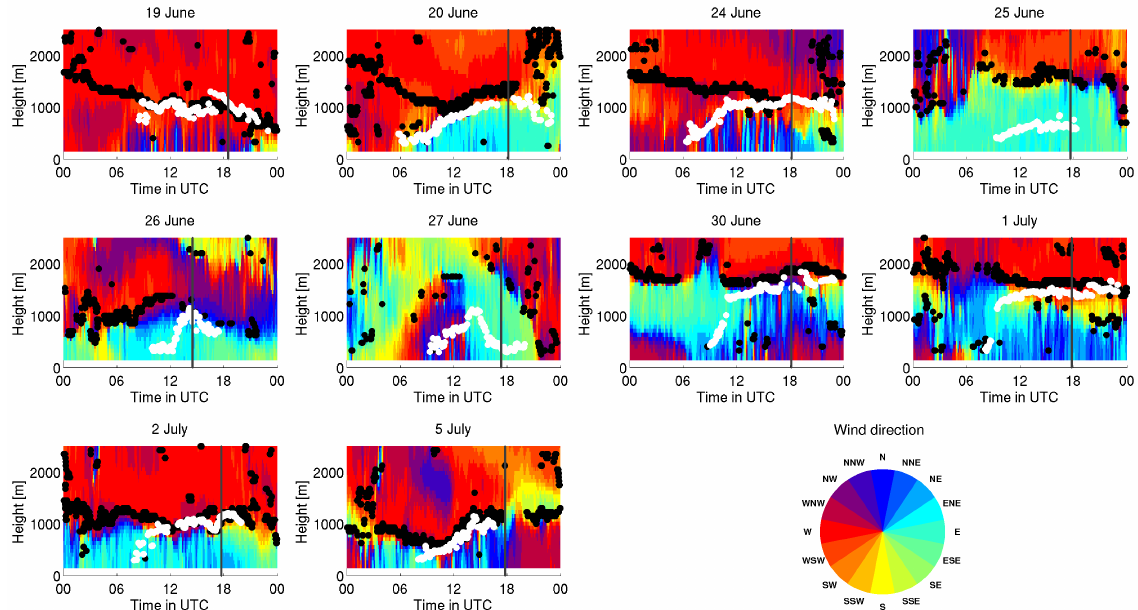
Figure A2. Wind direction from UHF profiler data between 175 and 2500m. The strongest wind speed gradient identification (black dots) most of the time separates the large-scale westerly flow above from the flow below. During daytime the flow below in the boundary layer is often easterly (or northerly). Also shown in white are the boundary layer depth estimates from the UHF wind profiler. A vertical line has been included to mark the timing of zero-buoyancy flux at